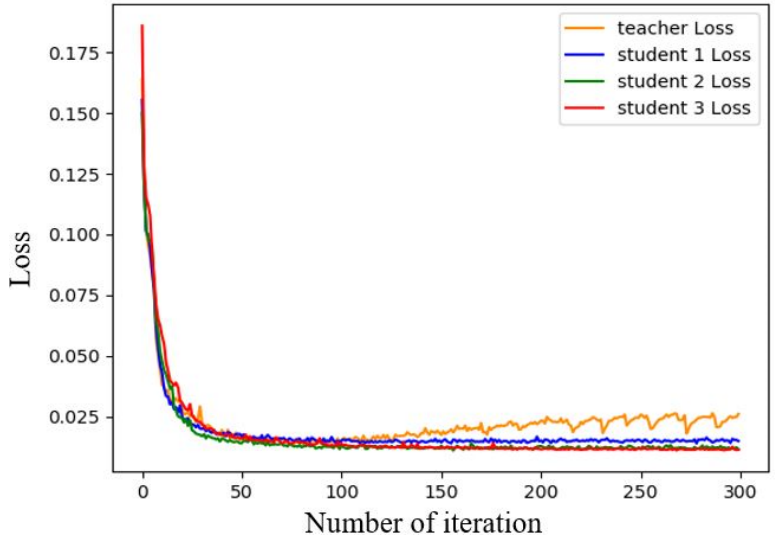
Figure 19. Semi-supervised learning validation dataset loss.